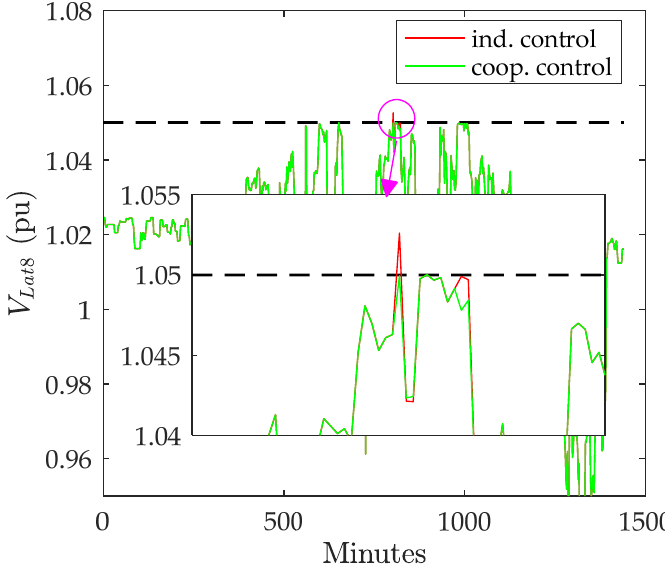
Figure 18. Voltage on lateral 8 with individual control and cooperative control.